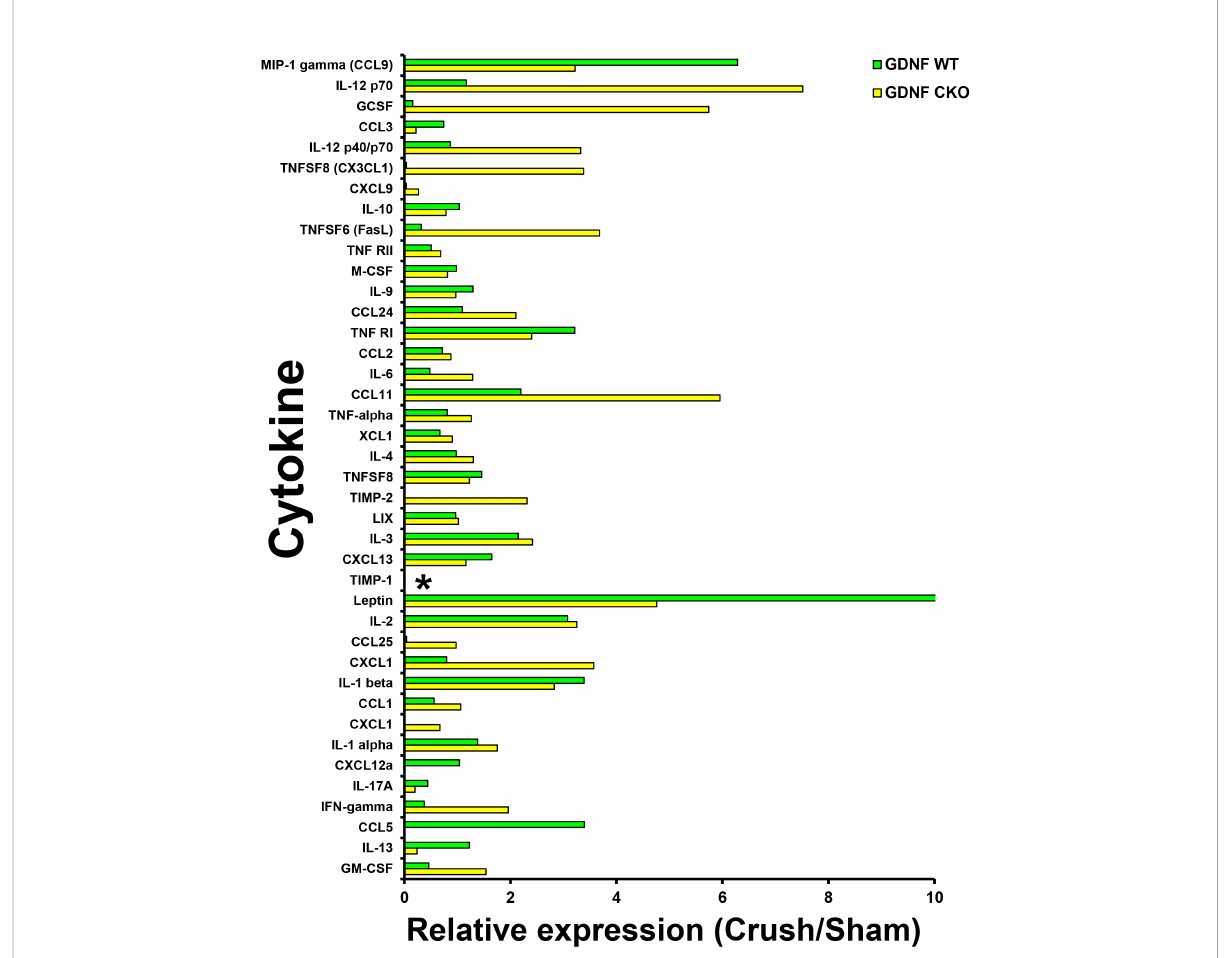
FIGURE 10 Sciatic nerve cytokine expression pro fi les in age- and sex-matched Gdnf CKO and Gdnf WT mice following unilateral crush injury. Bar histograms from a representative whole sciatic nerve homogenate semi-quantitative cytokine array spot densitometry experiment demonstrating relative cytokine expression in injured sciatic nerves compared to uninjured (Sham control) sciatic nerves are shown. TIMP-1 is expressed only in Gdnf CKO injured sciatic nerves. * indicates a ratio of in fi nity. N = 4 (16 sciatic nerves in